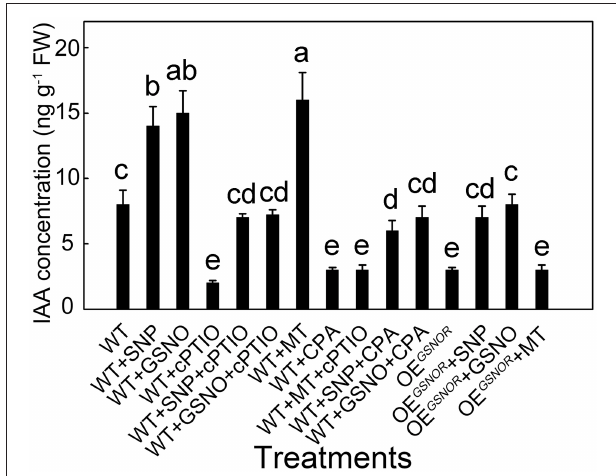
FIGURE 6 | IAA concentration with different treatments during adventitious root development in the hypocotyl sampled at 12 h. Values are expressed as means of five replicates ± SD, and different letters indicate significant difference ( p <